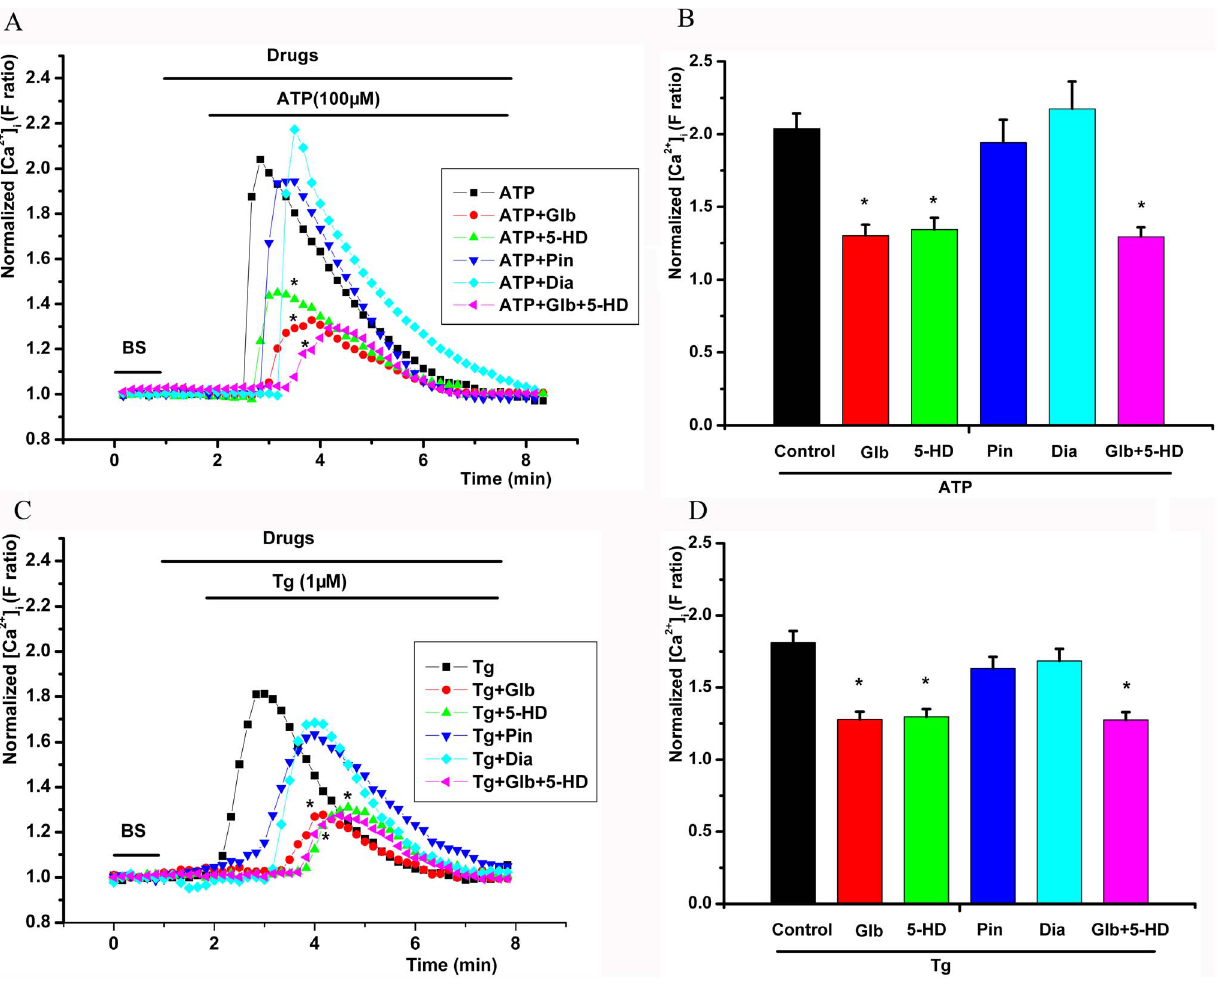
Figure 3. Effect of glibenclamide on the [Ca 2 + ] i transient elevation induced by extracellular ATP. A, C, time series of the mean F ratio during the application of different agents. B, D, the maximal [Ca 2 + ] i with different agents. Glibenclamide (100 m M) and 5-hydroxydecanoate (5-HD, 100 m M) decreased the ATP- or Tg-induced peak [Ca 2 + ] i ; pinacidil (100 m M) did not change the maximal [Ca 2 + ] i ; diazoxide (Dia, 100 m M) increased the peak [Ca 2 + ] i without significant differences. * P , 0.05, compared with the control. BS, bath solution.